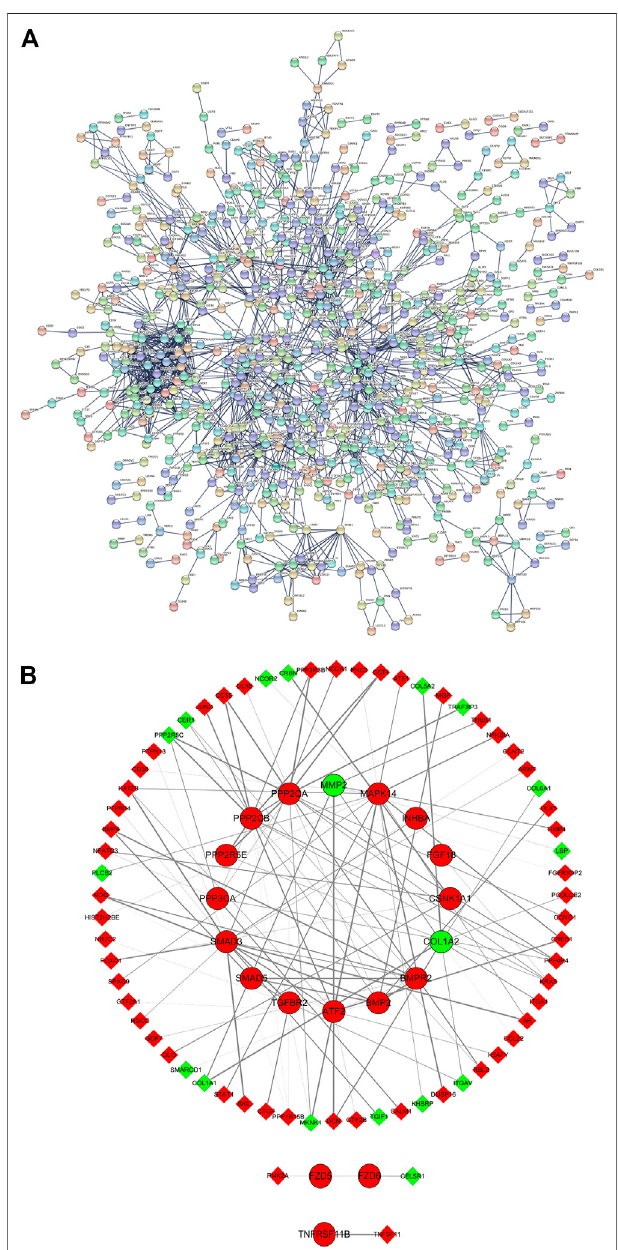
FIGURE 5 | PPI analysis. (A) All DE mRNAs PPI network; (B) PPI sub network of 19 DE mRNAs and their interacting proteins. Red and green ellipses were upregulated and downregulated DE mRNAs, respectively. Red and green diamonds were upregulated and downregulated DE mRNAs, respectively. PPI, protein-protein interaction. DE, differentially expressed.